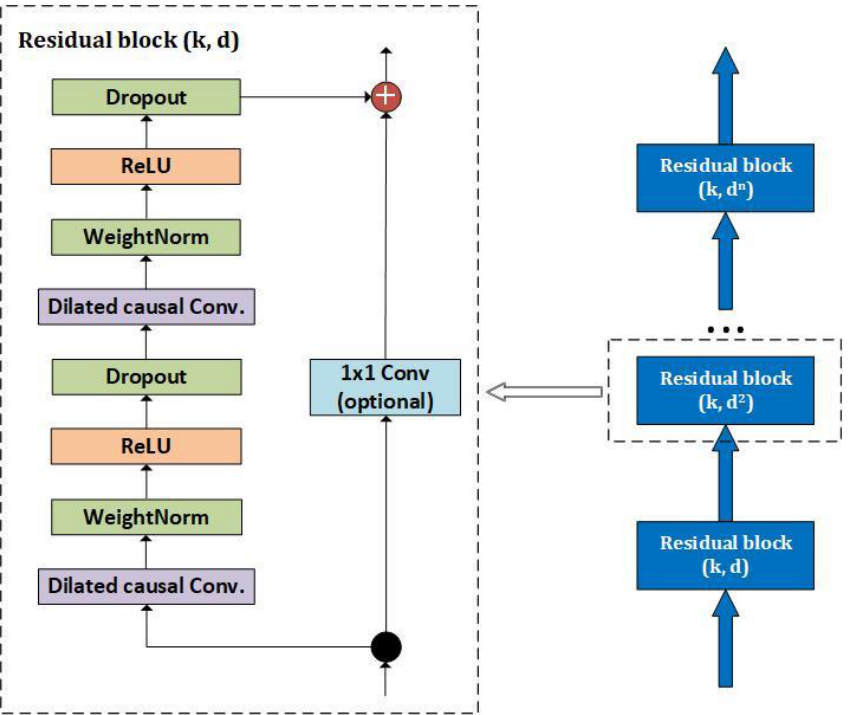
Figure 2. Residual block architecture in TCN model.